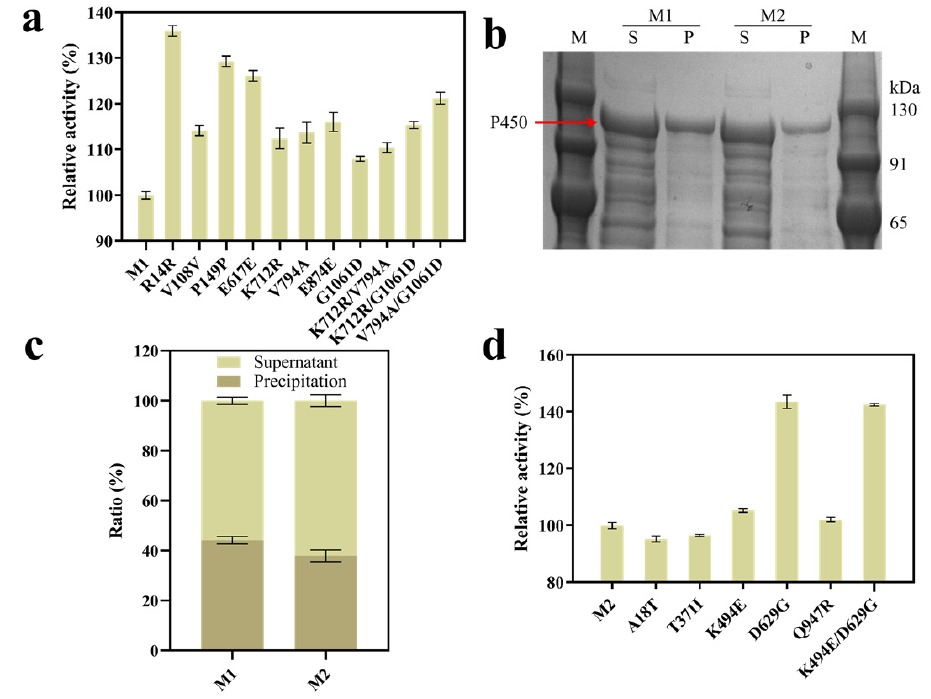
Figure 4. Combinatorial mutagenesis of hot spots identified in directed evolution. ( a ) With M1 as the parent, single-point mutants and combined mutants were constructed according to the results of the first round of screening, and each mutant contained the G307A mutation. The enzyme activity of M1 was set as 100%. ( b ) The expression of M1 and M2 (cyp153a-ncp G307A/R14R ). Lane M, marker; lane S, supernatant; lane P, precipitation. ( c ) Expression analysis of P450 mutants. SDS-PAGE protein electrophoresis results were analyzed by ImageJ software to calculate the proportions of P450 in the supernatant and the precipitation of M1 and M2, respectively. ( d ) With M2 as the parent, single-point mutants and combined mutants were constructed according to the results of the second round of screening, and each mutant contained the G307A/R14R mutation. The enzyme activity of M2 was set as